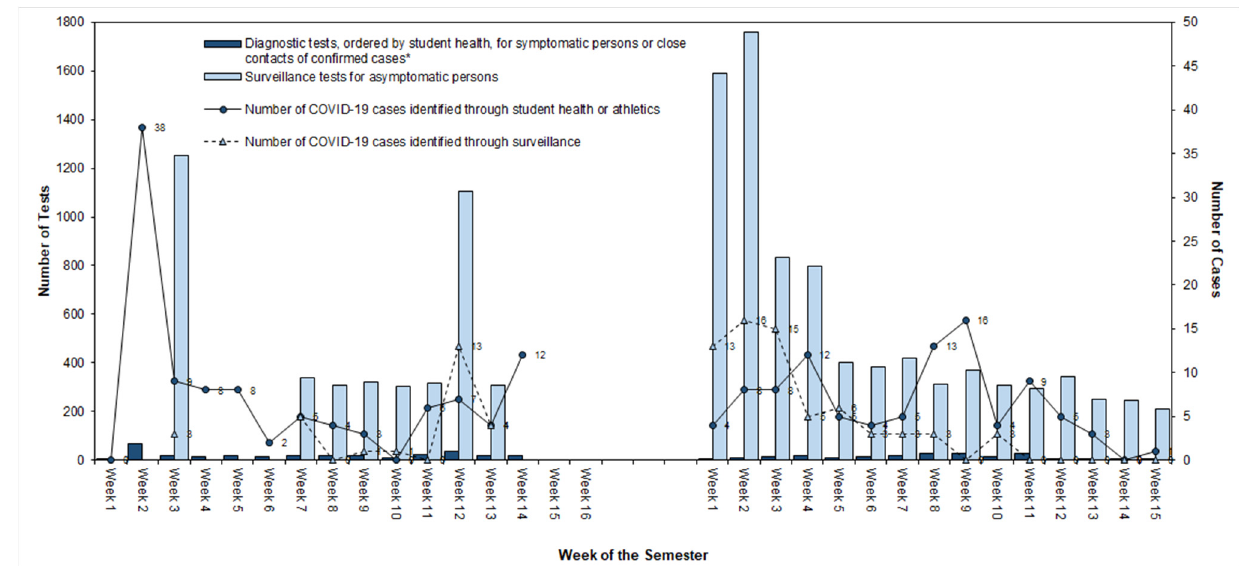
Figure 2. Number of RT-PCR COVID-19 tests performed by testing strategy and number of COVID-19 cases on a university campus, South Carolina, August 2020—April 2021. Abbreviations: COVID-19 = coronavirus 2019; RT-PCR = reverse transcription-polymerase chain reaction. * Tests conducted through university Athletics surveillance program data not shown.